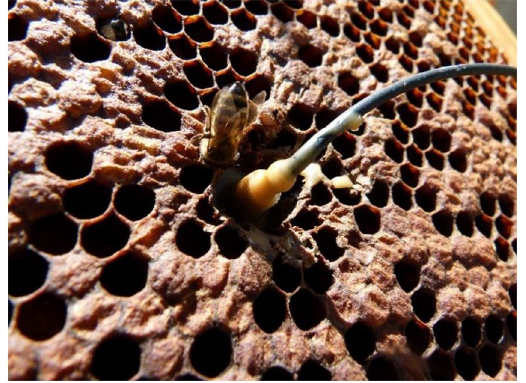
Figure 12. A Brüel and Kjaer piezoelectric Type 4508 accelerometer installed in the centre of a frame from a bee